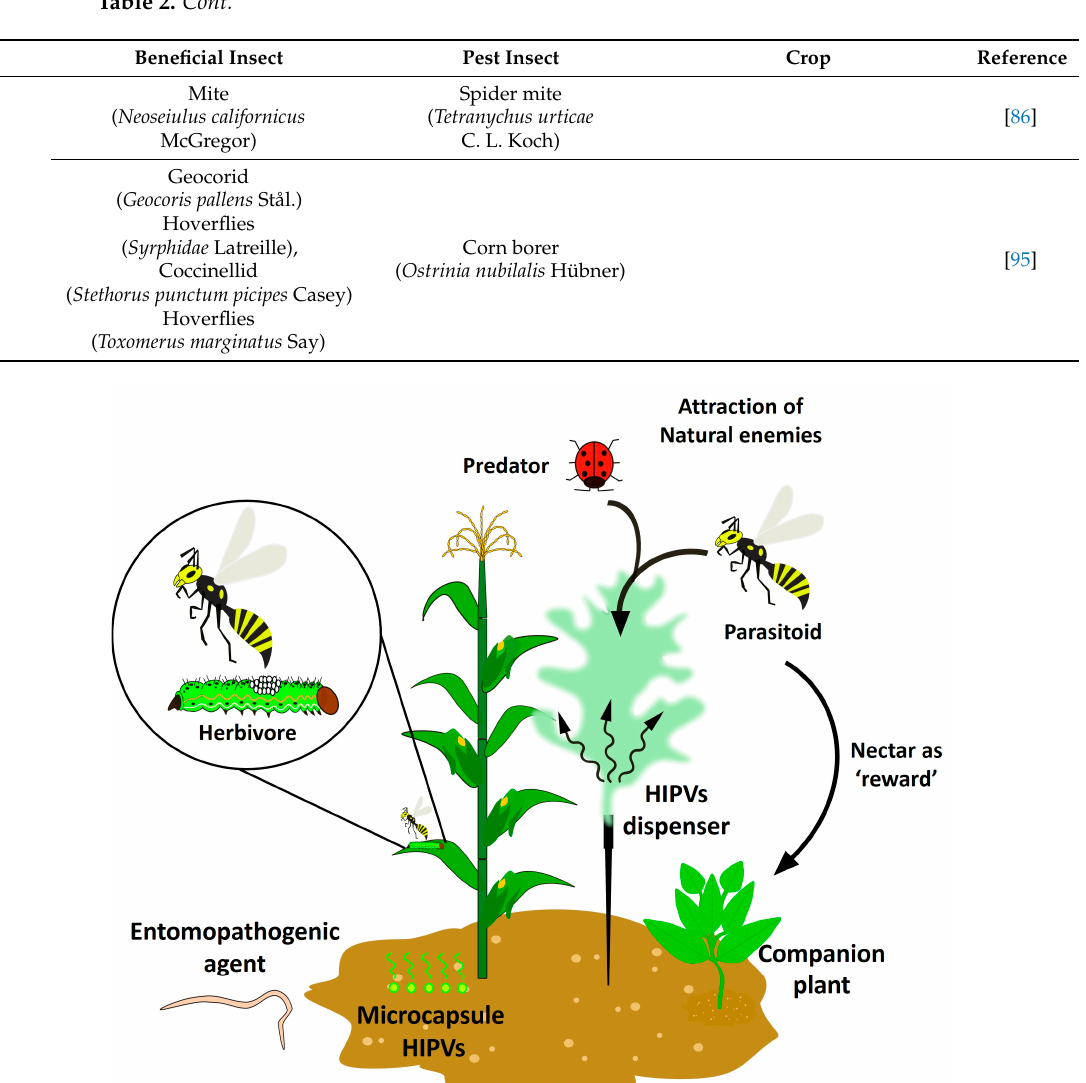
Figure 4. The “attract and reward” method is a pest control strategy that enhances the efficiency and survival periods of natural enemies (parasitoids and predators), which allows the establishment of stable populations. Table 2. Herbivore-induced plant volatiles with attraction capacity of natural enemies.